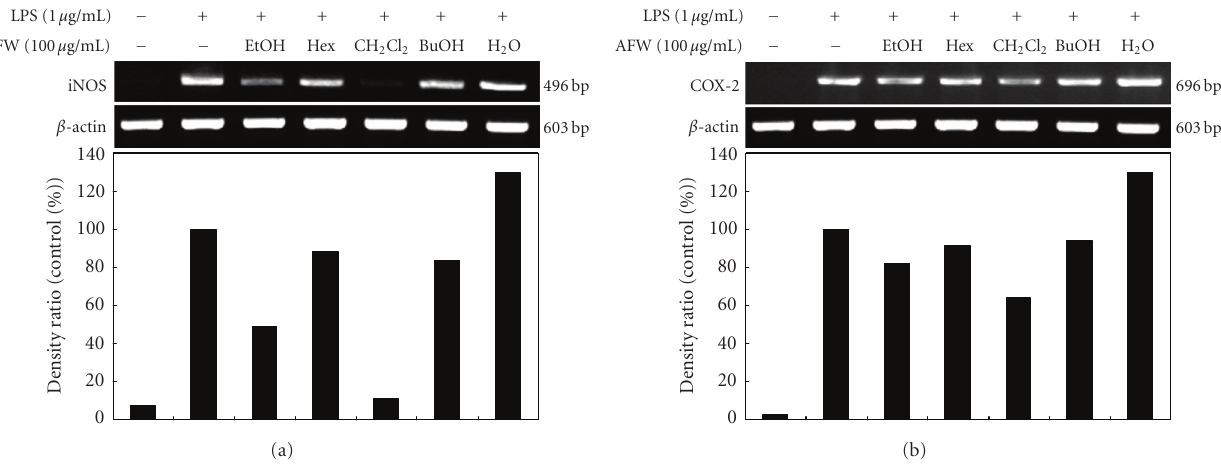
Figure 3: Inhibitory e ff ects of AFW extracts and solvent fractions on iNOS (a) and COX-2 (b) mRNA expression in RAW 264.7 cells. RAW 264.7 cells (5.0 × 10 5 cells/mL) were pre-incubated for 18 hours, and the iNOS mRNA expression was determined in cells stimulated with LPS (1 μ g/mL) for 24 hours in the presence of 80% EtOH extract and solvent fractions (100 μ g/mL) of AFW.